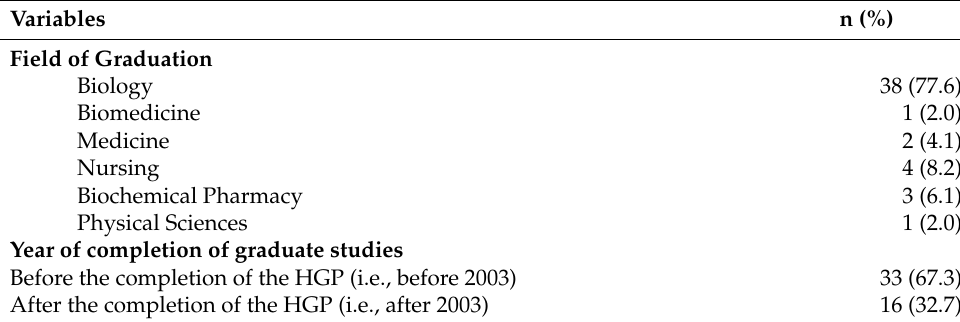
Table 3. Demographic data and characterization of the instructors responsible for the genetics content for the undergraduate nursing